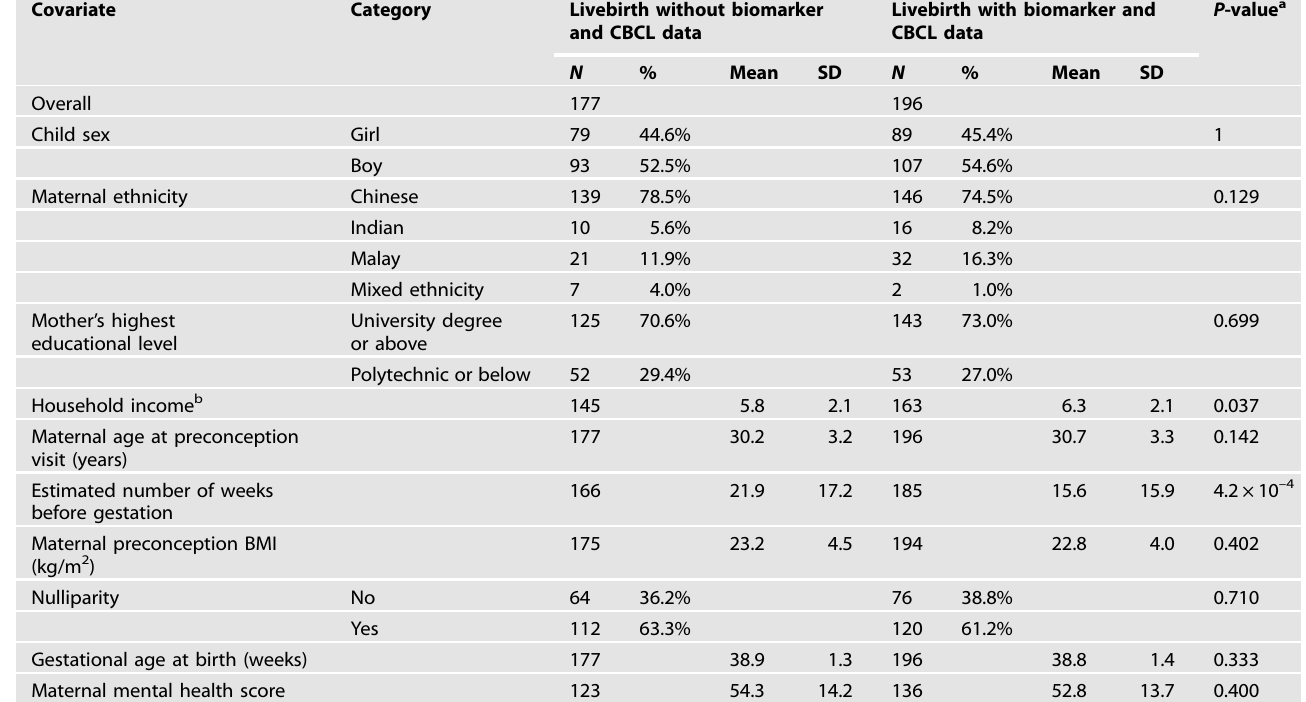
Table 1. Comparisons of characteristics between the participants with and without biomarker and CBCL data (among those who had given